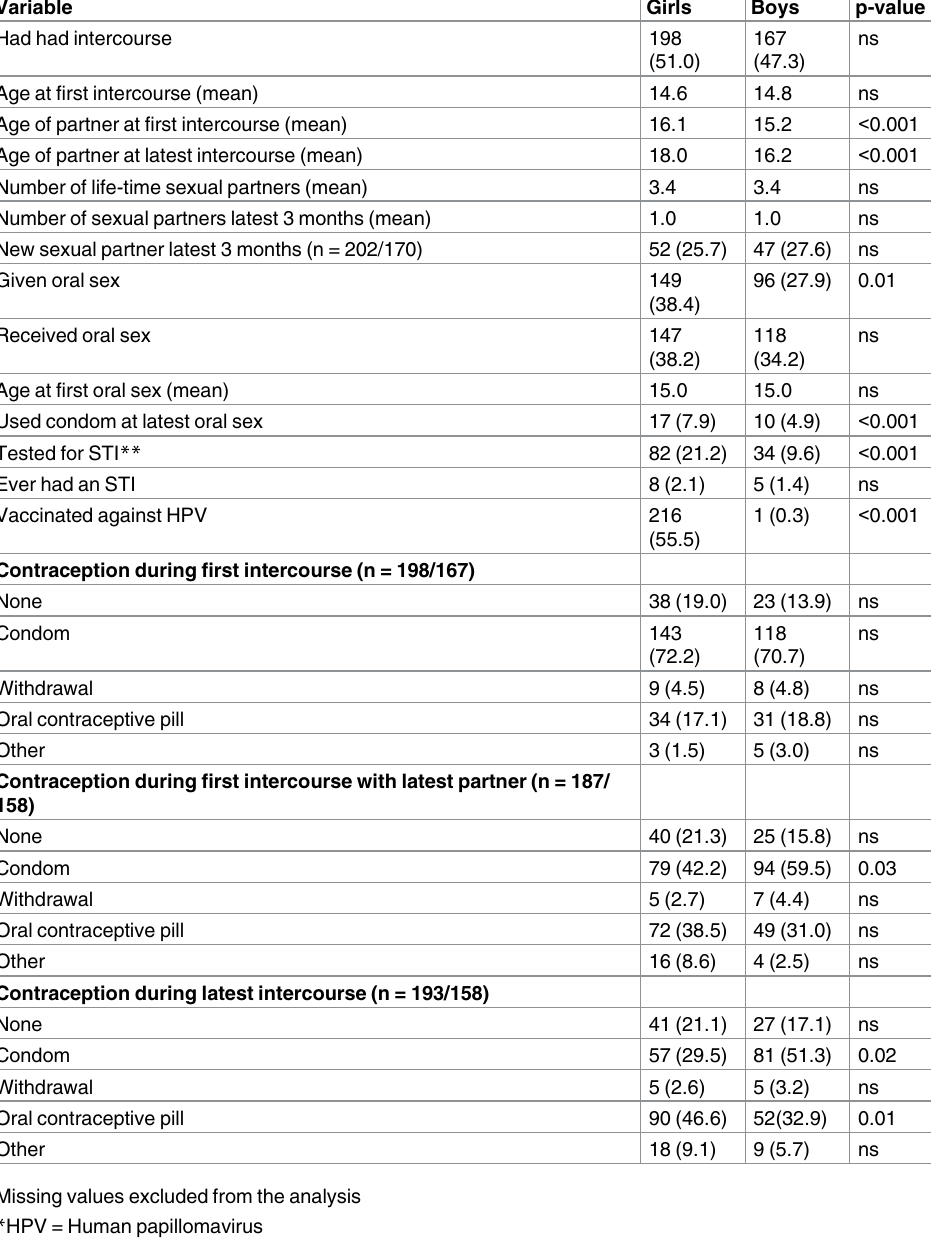
Table 3. Sexual experiences, HPV * vaccination status and contraceptive use among sexually active